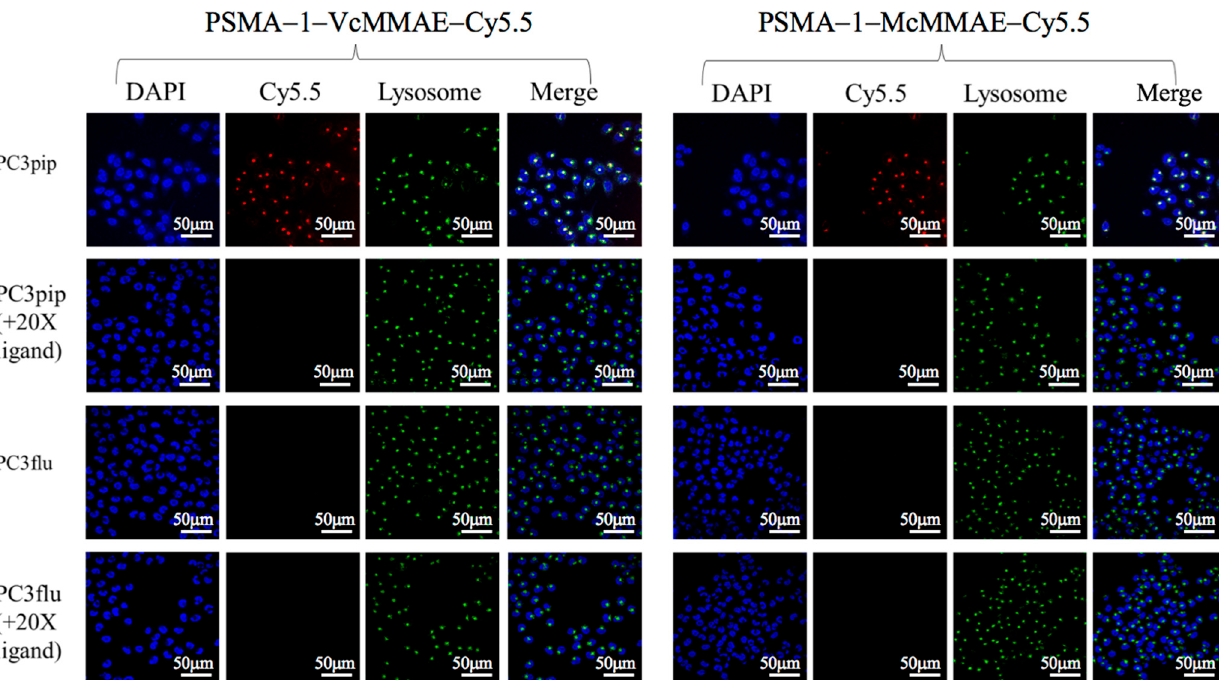
Figure 2. In vitro fluorescence studies of PSMA-1-MMAE-Cy5.5 conjugates. In vitro cellular uptake results of PSMA-targeted drug conjugates. Cells were incubated with 50 nM of drug conjugates for 4 h. Nuclei were stained by DAPI and are false colored blue, lysosomes were detected by LysoOrange and are false colored green, and drug conjugates are false colored red. Selective uptake was observed only in PC3pip cells and the conjugates were mainly located in lysosomes. Specificity of drug conjugates for PSMA binding was evaluated by including 1 mM of unlabeled PSMA-1 ligand during incubations. Signal in PC3pip cells was significantly competed by PSMA-1, suggesting the binding is selective. Images are taken at 40×. Representative images are shown from three independent experiments.